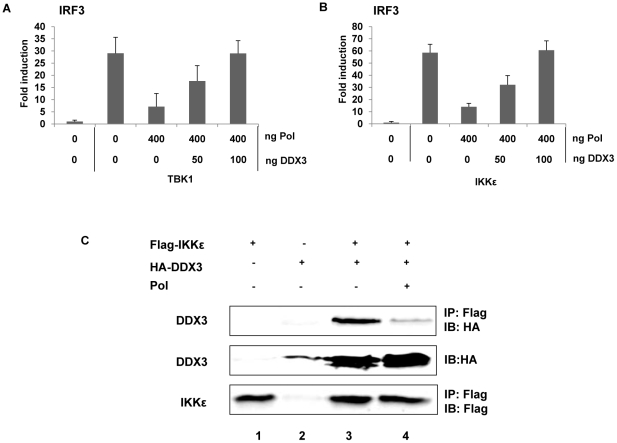
HBV Pol inhibits TBK1/IKKε via an interaction with DDX3.(A and B) DDX3 rescued IRF signaling, which was inhibited by HBV Pol. HepG2 cells were transfected with indicated amounts of HBV Pol and DDX3 expression constructs. To induce IRF3 signaling, TBK1 (A) or IKKε (B) expression constructs (100 ng) were transfected. IRF3 activation was monitored as shown in Fig. 4. Data are expressed as the mean fold induction ± s.d. relative to control levels. The results are representative of at least two independent experiments each performed in triplicate. (C) HBV Pol disrupted the interaction between DDX3 and IKKε. HEK 293 cells were transfected with Flag-IKKε, HA-DDX3, and HBV Pol expression constructs. Cell lysates were analyzed by IP with the indicated antibodies to assess the interaction between DDX3 and IKKε. For the detection of the Flag-tagged IKKε, mouse anti-FLAG M2 antibody (Sigma, 1∶5,000) was used; anti-HA antibody (Amersham) was used to detect DDX3. The results are representative of three independent experiments.